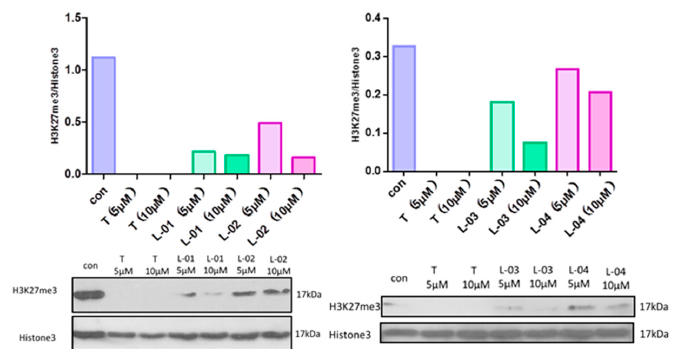
Figure 3. Effect of L–01 ~ L–04 on cellular H3K27Me3 levels as determined by western blot analysis. Western blot analysis of H3K27Me3 and Histone3 from whole cell extracts on K562 cells after treatment of 72 h. The letter T is abbreviation of tazemetostat.